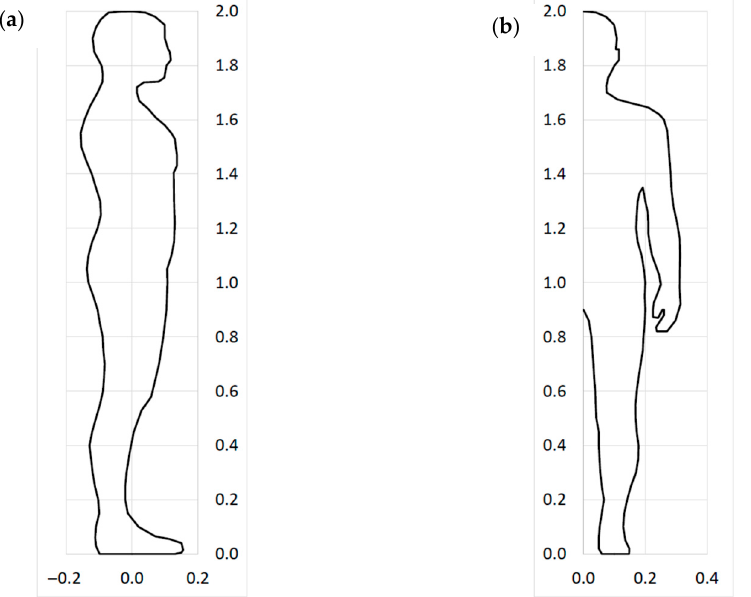
Figure 6. Human figure defined as a scalable set of points in the scanner coordinate system: ( a ) in the xz plane, ( b ) in the yz plane. Table 2. Geometrical parameters characterizing the arrangement of the HUBO scanner cameras for an exemplary numerical